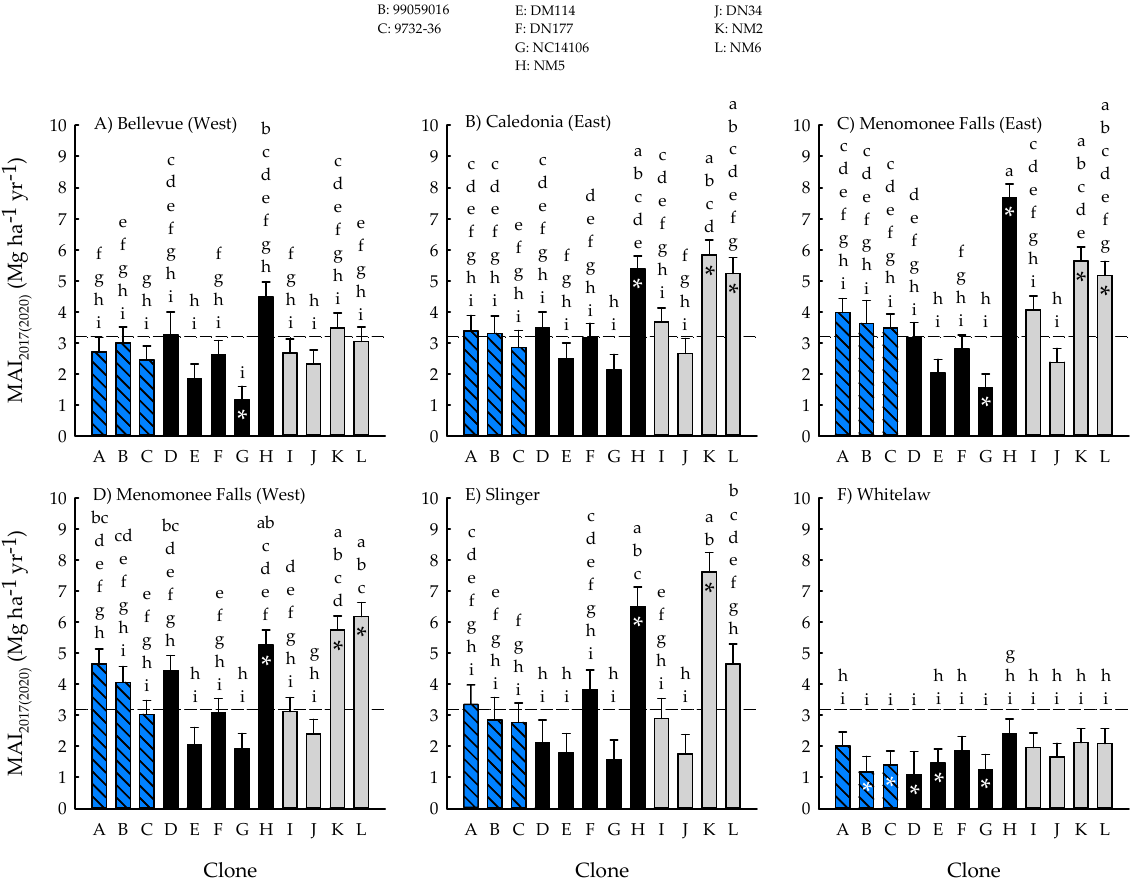
Figure 5. Mean annual increment (Mg ha − 1 yr − 1 ) (±one standard error) determined after the 2020 growing season of twelve poplar clones tested in six phytoremediation buffer systems (i.e., phyto buffers) ( A – F ) established in 2017 (i.e., the 2017 buffer group) in the Lake Michigan watershed of eastern Wisconsin, USA. The dashed line represents the overall mean, and asterisks indicate means different than the overall mean at P < 0.05. Bars with different letters across all buffer × clone combinations are different at P < 0.05.